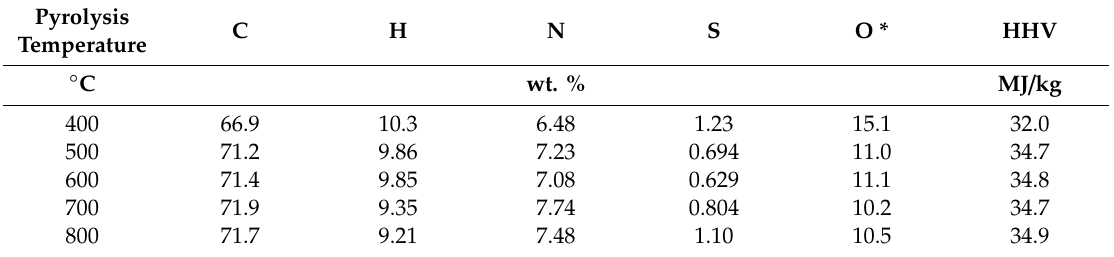
Table 4. Ultimate analysis and heating value of the organic condensate fractions.